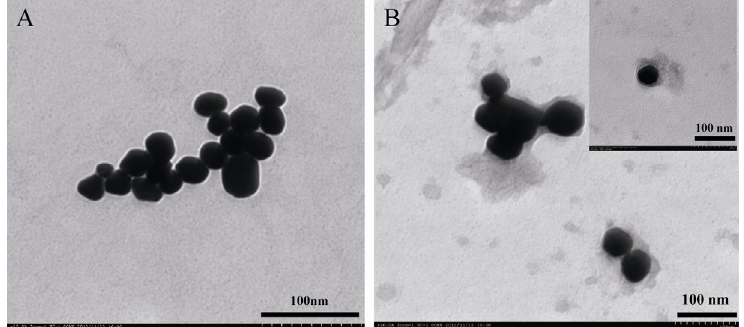
Figure 1. Transmission electron micrographs images of AuNPs ( A ) and /glucoamylase/AuNPs ( B Ab 2